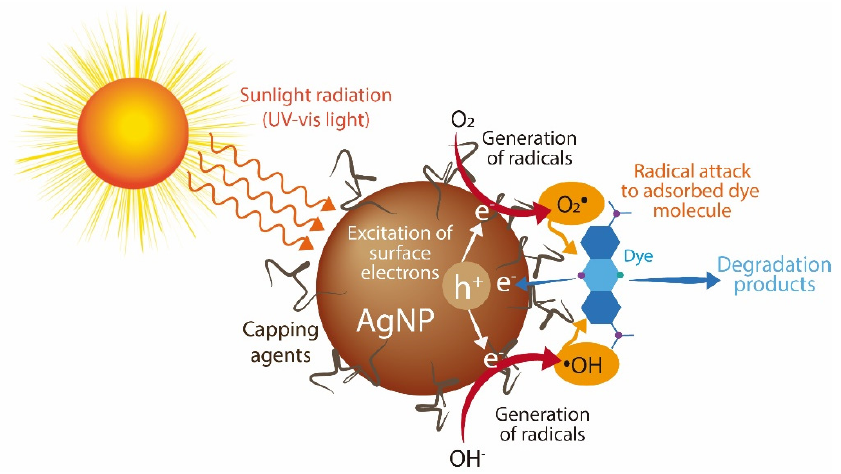
Figure 7. Photocatalysis mechanism of AgNPs under UV and visible light radiation for dye degra- dation.